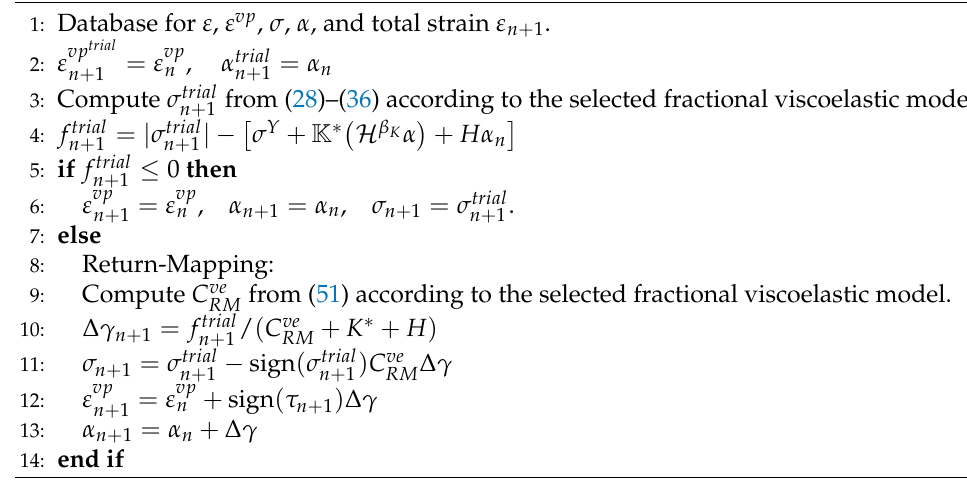
Algorithm 1 Fractional return-mapping